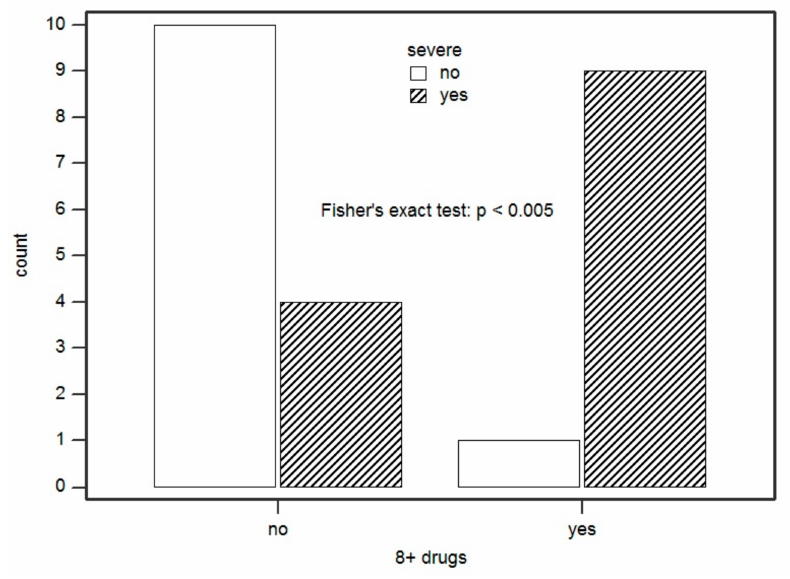
Figure 3. Association between having eight or more medications on therapy and developing a severe reaction. Count = number of patients.